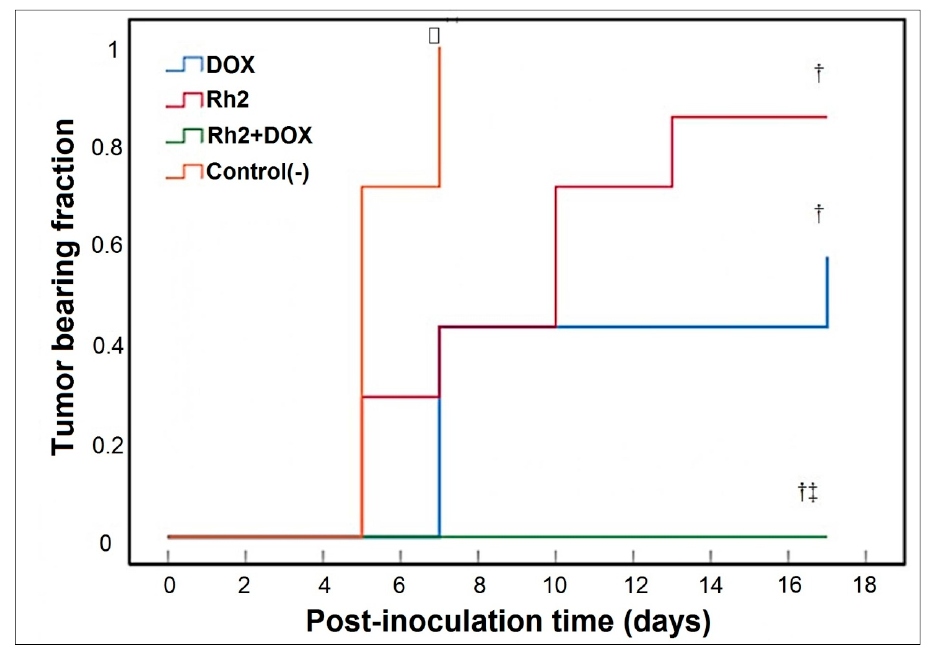
Figure 2. Result of delayed treatment on tumor growth (Variant B, early treatment protocol). Time- course of measurable tumor development (Kaplan–Meier analysis; plotted as one minus event versus time) in animal groups with individual and combined treatment. Control(-)—non-treated animals, used as negative control. DOX—Doxorubicin alone (0.25 mg/kg); Rh2—Rh2 alone (10 mg/kg); DOX + Rh2—combined DOX and Rh2 treatment (0.25 mg/kg and 10 mg/kg). □ Log-rank (Mantel- Cox), p < 10 − 9 . † Pairwise post hoc log-rank versus control, p < 0.02. ‡ Pairwise post hoc log-rank versus Dox or Rh2, p < 0.02.